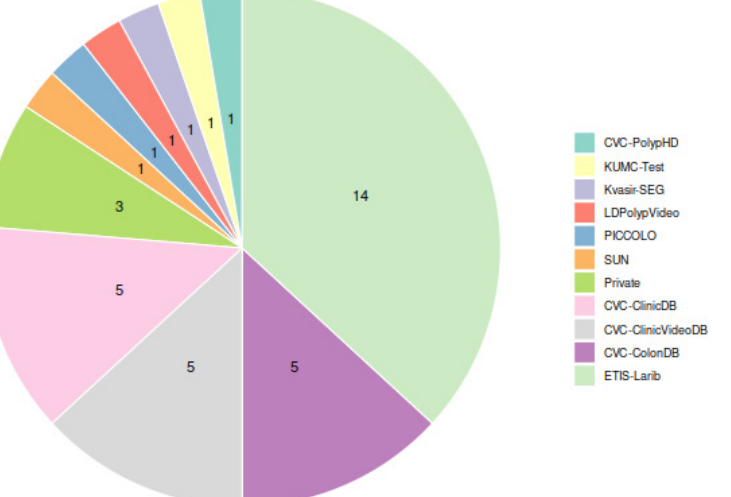
Figure 4. Usage of datasets for model evaluation among studies in Table 2. Each study using several datasets contributes one point for each testing dataset used.